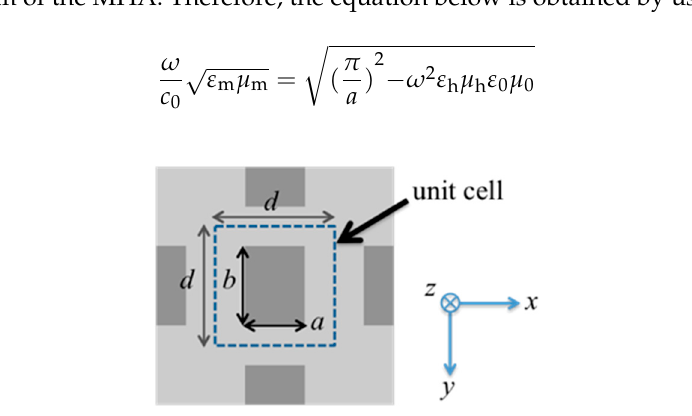
Figure 2. The unit cell of the MHA.